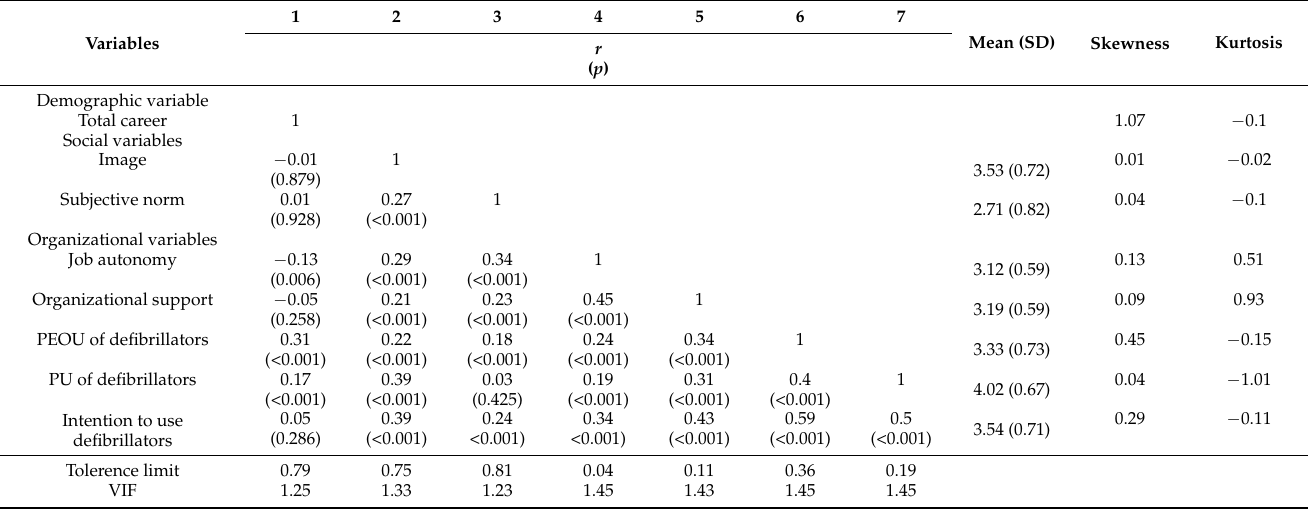
Table 2. Correlation, Tolerance, and Variation Inflation Factor among the Measured Variables ( N =